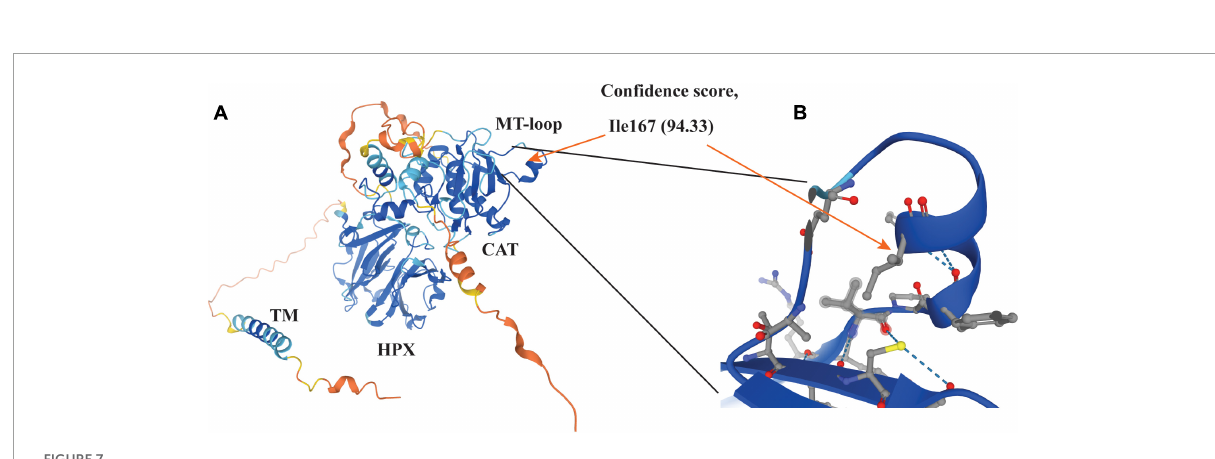
FIGURE7 Structure of MT1-MMP (A) and enlarged view of the MT-loop (B) The structure was adopted from AlphaFold (https://alphafold.ebi.ac.uk/search/text/MT1-MMP) (68). The model confidence scores of Ile167 are very high (94.33). The side chain of Ile167 is pointed to the inside of the MT-loop (orange arrow in panel B